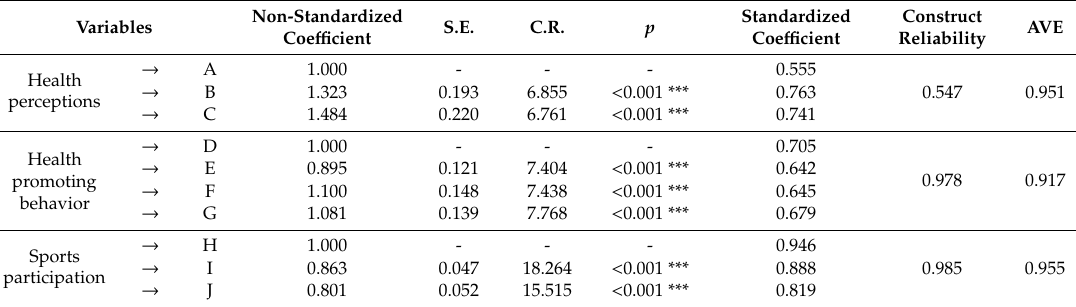
Table 4. Results of confirmatory factor analysis.